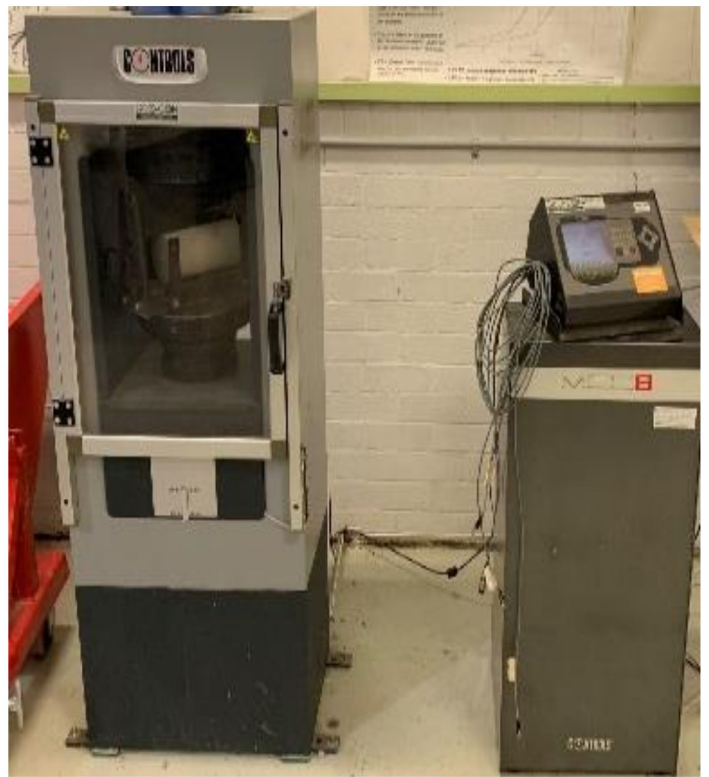
Figure 6. Indirect tensile strength test